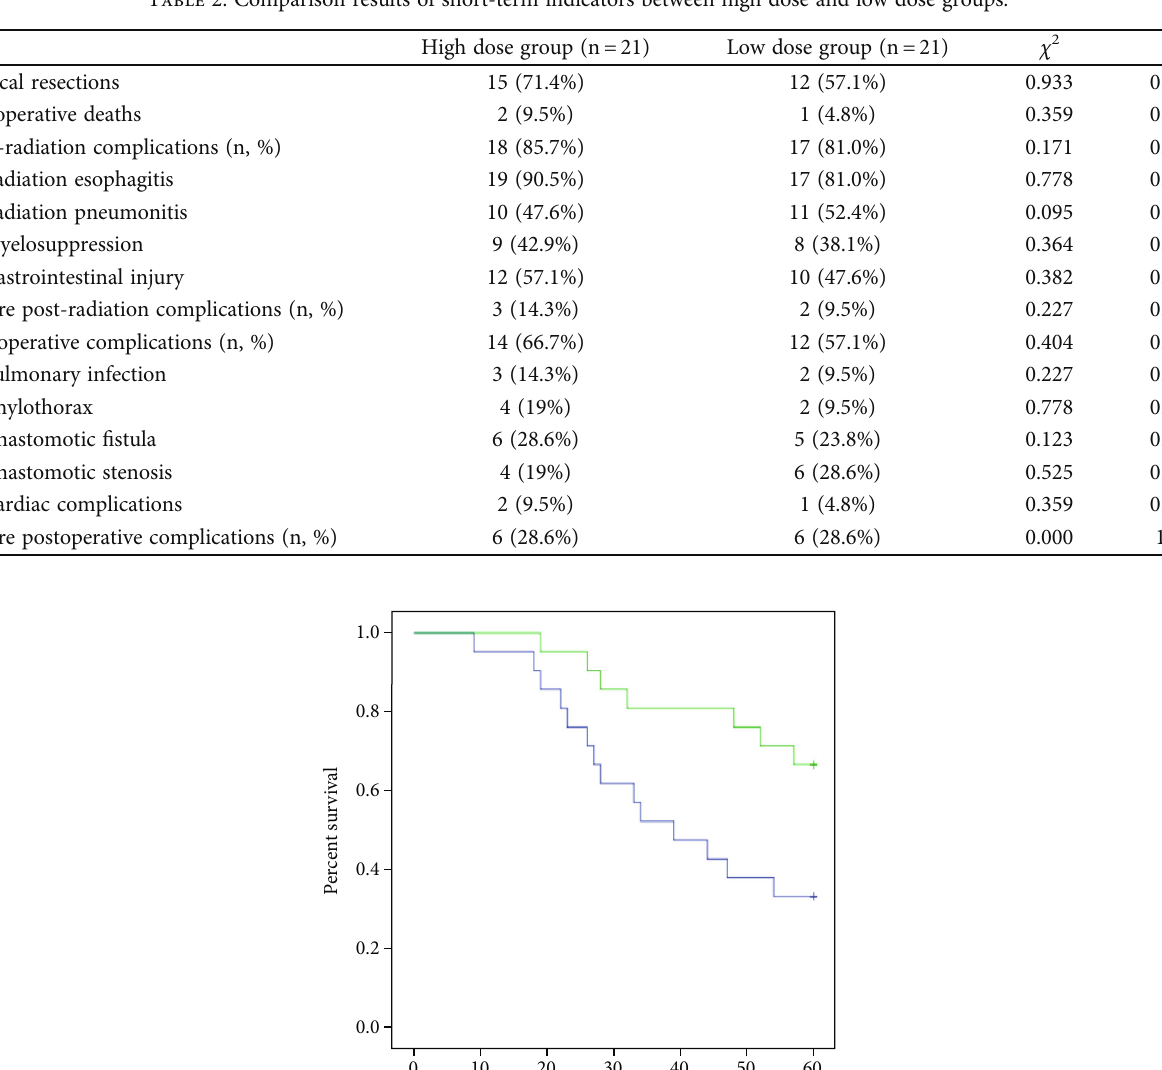
Table 2: Comparison results of short-term indicators between high dose and low dose groups.